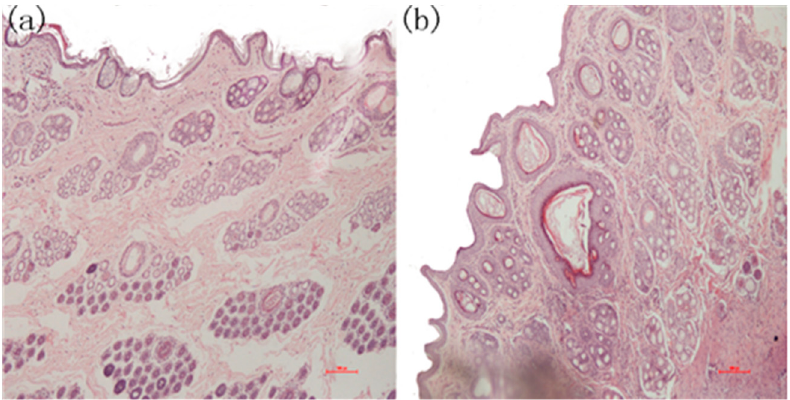
Figure 12. The microscopic state of the recovered wound tissue. ( a ) Skin pathological section from the PLA-PTMC group; ( b ) skin pathological section from the positive group.